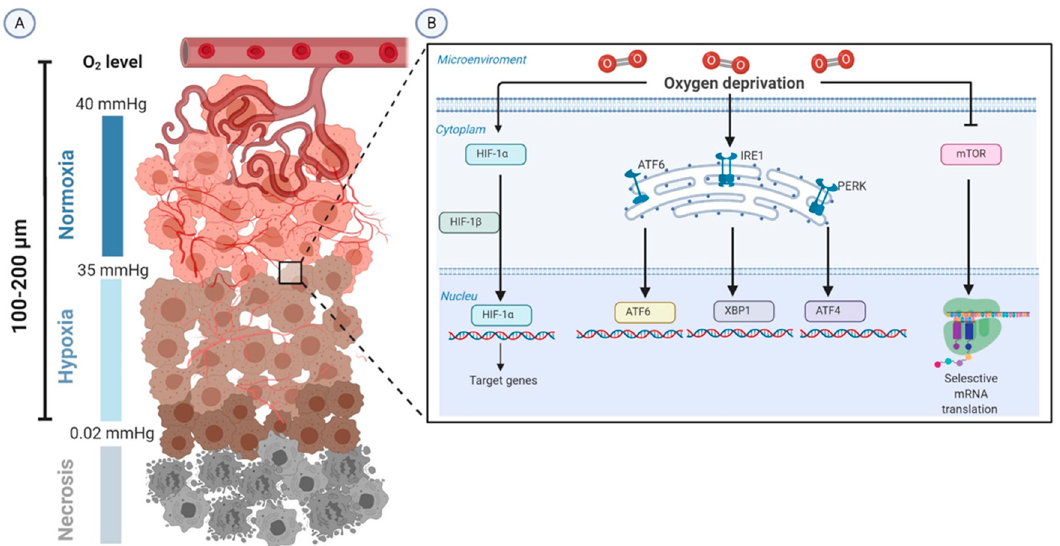
Figure 1. Schematic representation of the biology of tumor hypoxia. ( A ) The severe structural and functional abnormality of the tumor vasculature and the increase in di ff usion distances between tumor cells and blood vessels (100–200 µ m) lead to intratumoral hypoxia (oxygen tension 0.02–35 mmHg). ( B ) HIF-1 α is the molecular determinant that is upregulated in the adaptive responses to alterations in tissue oxygenation. Moreover, tumor hypoxia induces adaptive responses through enhancing unfolded protein response (UPR)-mediated upregulation of ATF6, XBP1, and ATF4 and inactivating the mTOR pathway. Abbreviations: ATF, activating transcription factor; HIFs, hypoxia-inducible factors; IRE1, inositol-requiring protein 1; mmHg, millimeter of mercury; mTOR, kinase mammalian target of rapamycin; O2, oxygen; PERK, protein kinase RNA-like endoplasmic reticulum (ER) kinase; XBP1, X-box binding